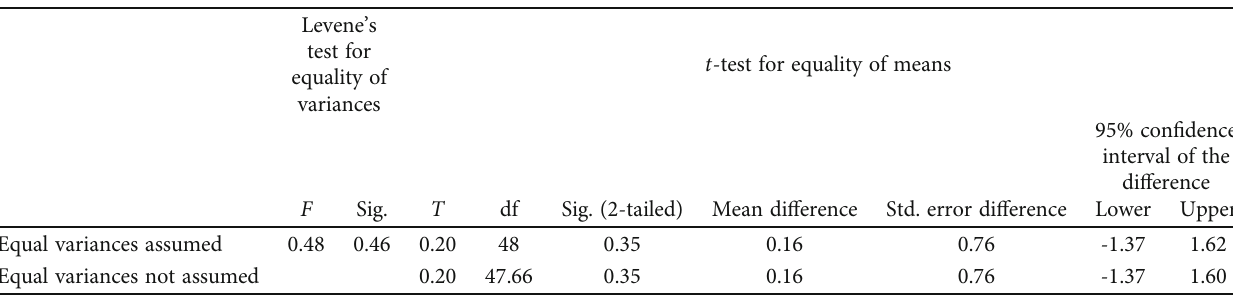
Table 2: Independent sample t -test (pretest of both groups).